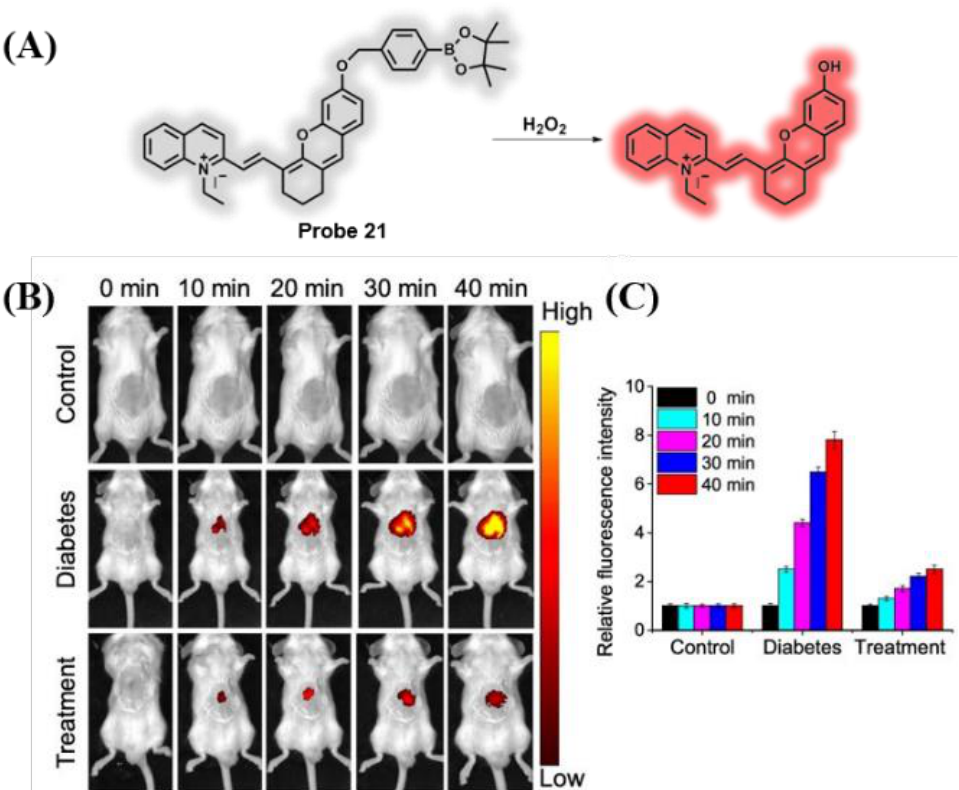
Figure 17. ( A ) Imaging mechanism of probe 21 ; ( B ) fluorescence imaging of mice in different groups (i.e., control group, diabetes group, and treatment group) over time after probe 21 (200 µ M) injection; ( C ) relative fluorescence intensity in panel ( B ). Conditions: λ ex = 640 nm, λ em = 680–780 nm. Adapted from Reference [97]. Copyright 2021, American Chemical Society.